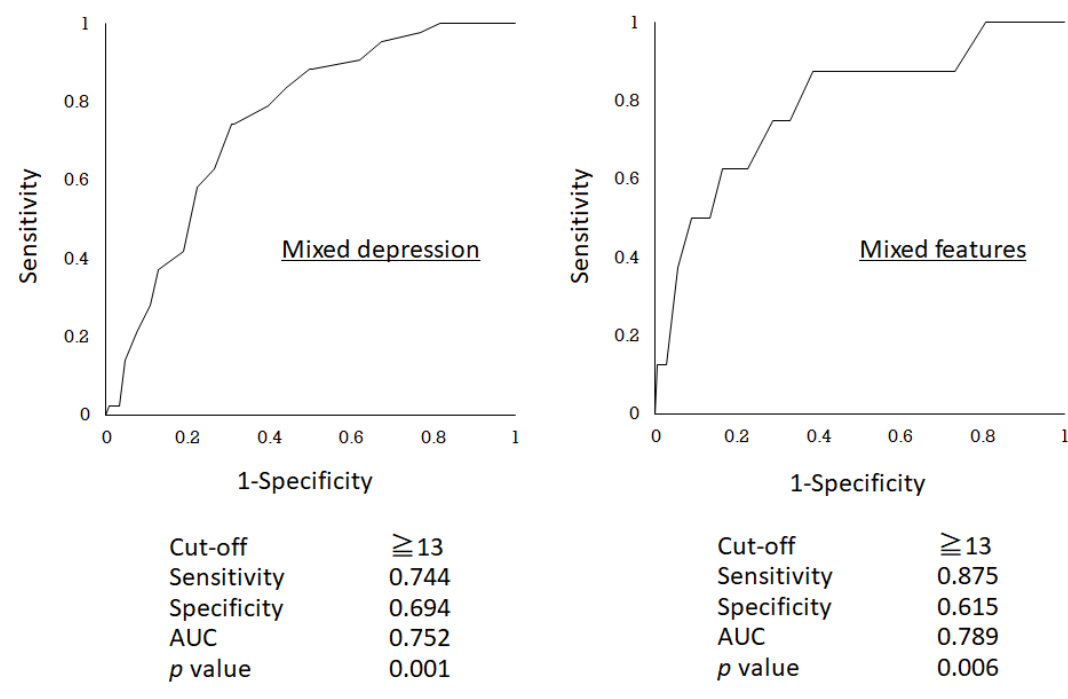
Figure 1. Receiver operating characteristic (ROC) curves determining mixed depression or mixed features by selective 8 mixed symptoms (overreactivity, inner tension, racing / crowded thought, impulsivity, irritability, aggression, risk-taking behavior, and dysphoria).